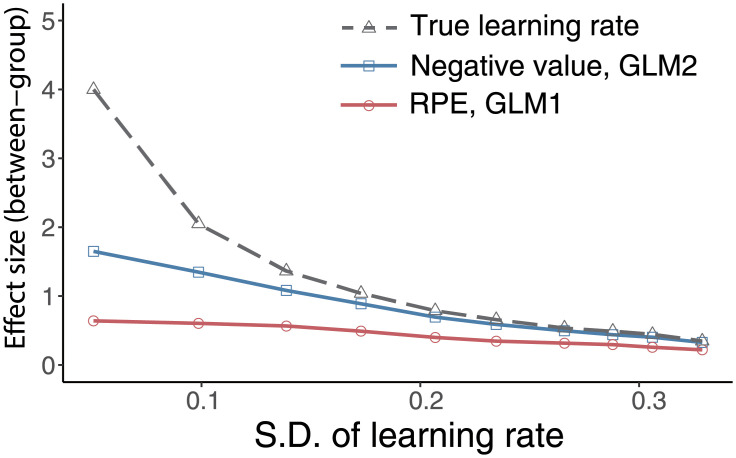
The effects of within-group differences in true learning rates on beta values (regression coefficients) and true learning rate.The between-group effect size of learning rate (gray), RPE of GLM1 (red), and negative value of GLM2 (blue) are plotted as a function of the standard deviation (s.d.) of true learning rate. The s.d. of learning rate is calculated for each group and then averaged across groups. Note that the s.d. is calculated for the actual parameter value after the truncation that restricts the range of learning rate to [0, 1].